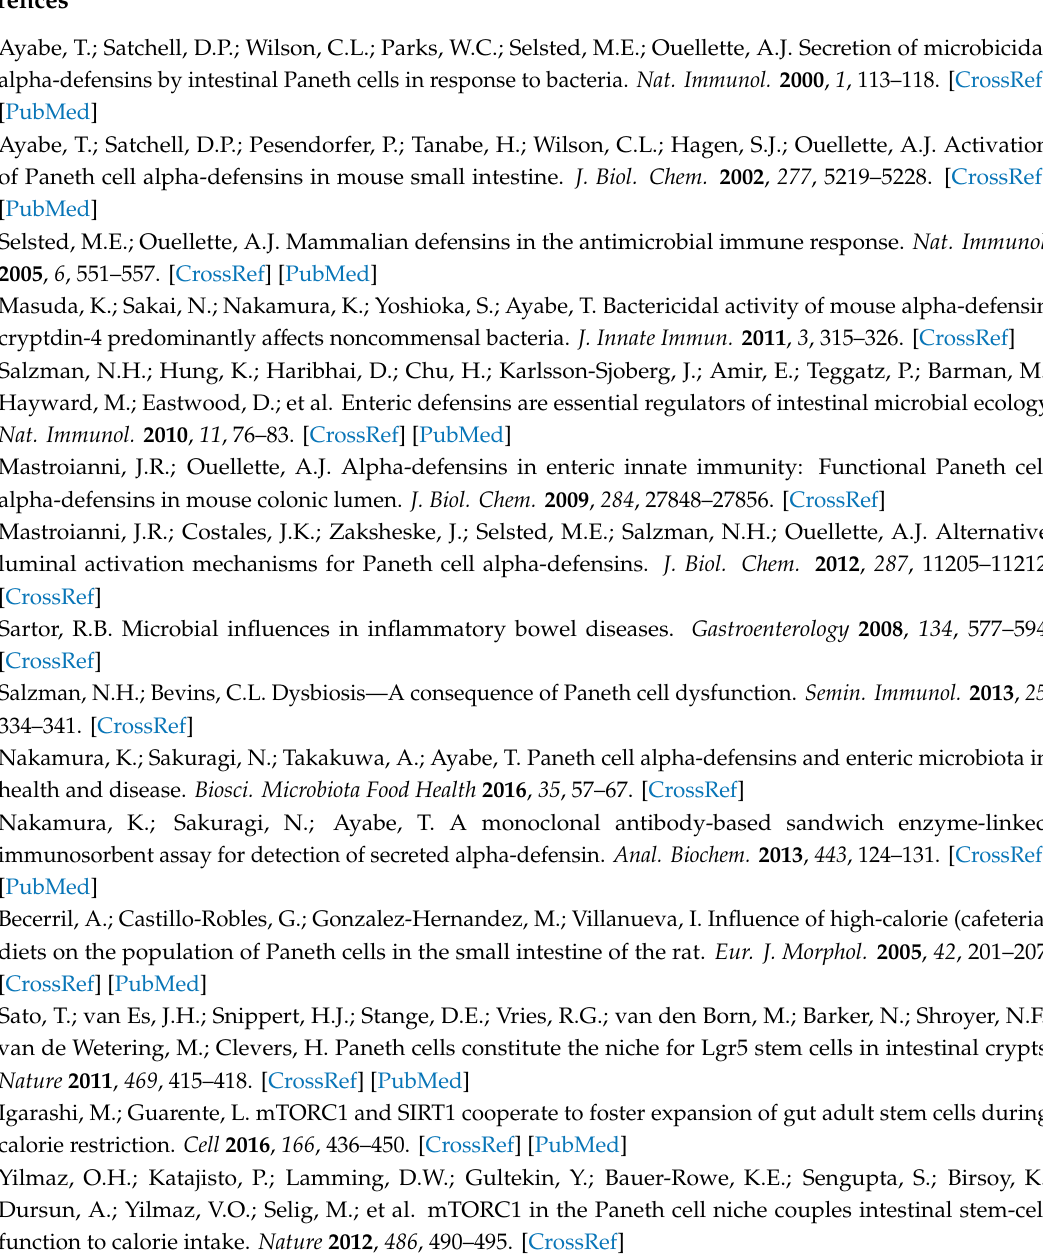
(b) Analysis of Paneth cell Crp1 secretion in response to 100 nM–10 µ M leucine. Figure S3: Comparison with the granule secretion before and after by SCFA or amino acid injection. Figure S4: Quantification of granule secretion by Paneth cell stimulated from the basolateral